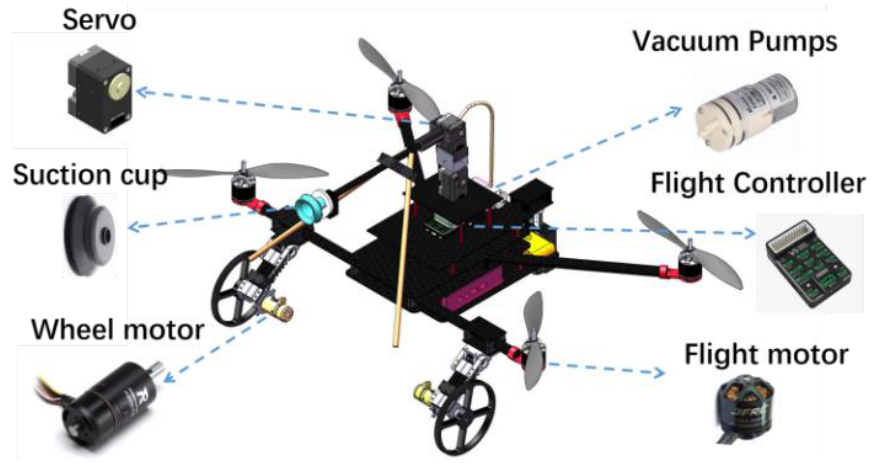
Figure 1. The overall structure of the robot (LAWCDR).